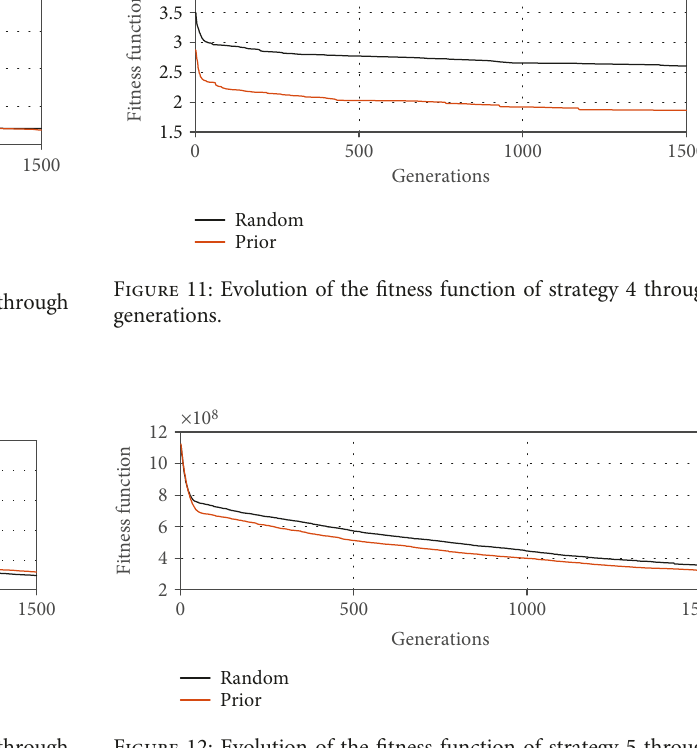
Figure 12: Evolution of the fi tness function of strategy 5 through